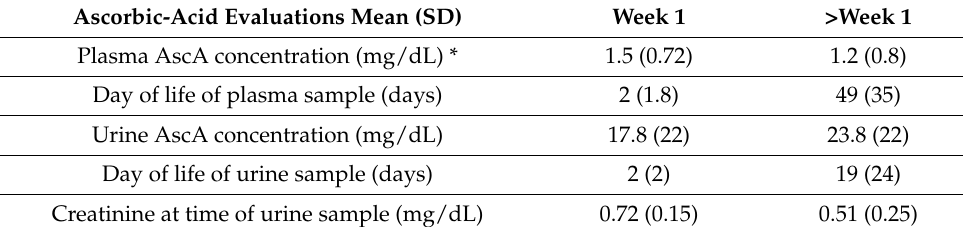
Table 3. Ascorbic-acid assessment of study population over time ( n = 63).